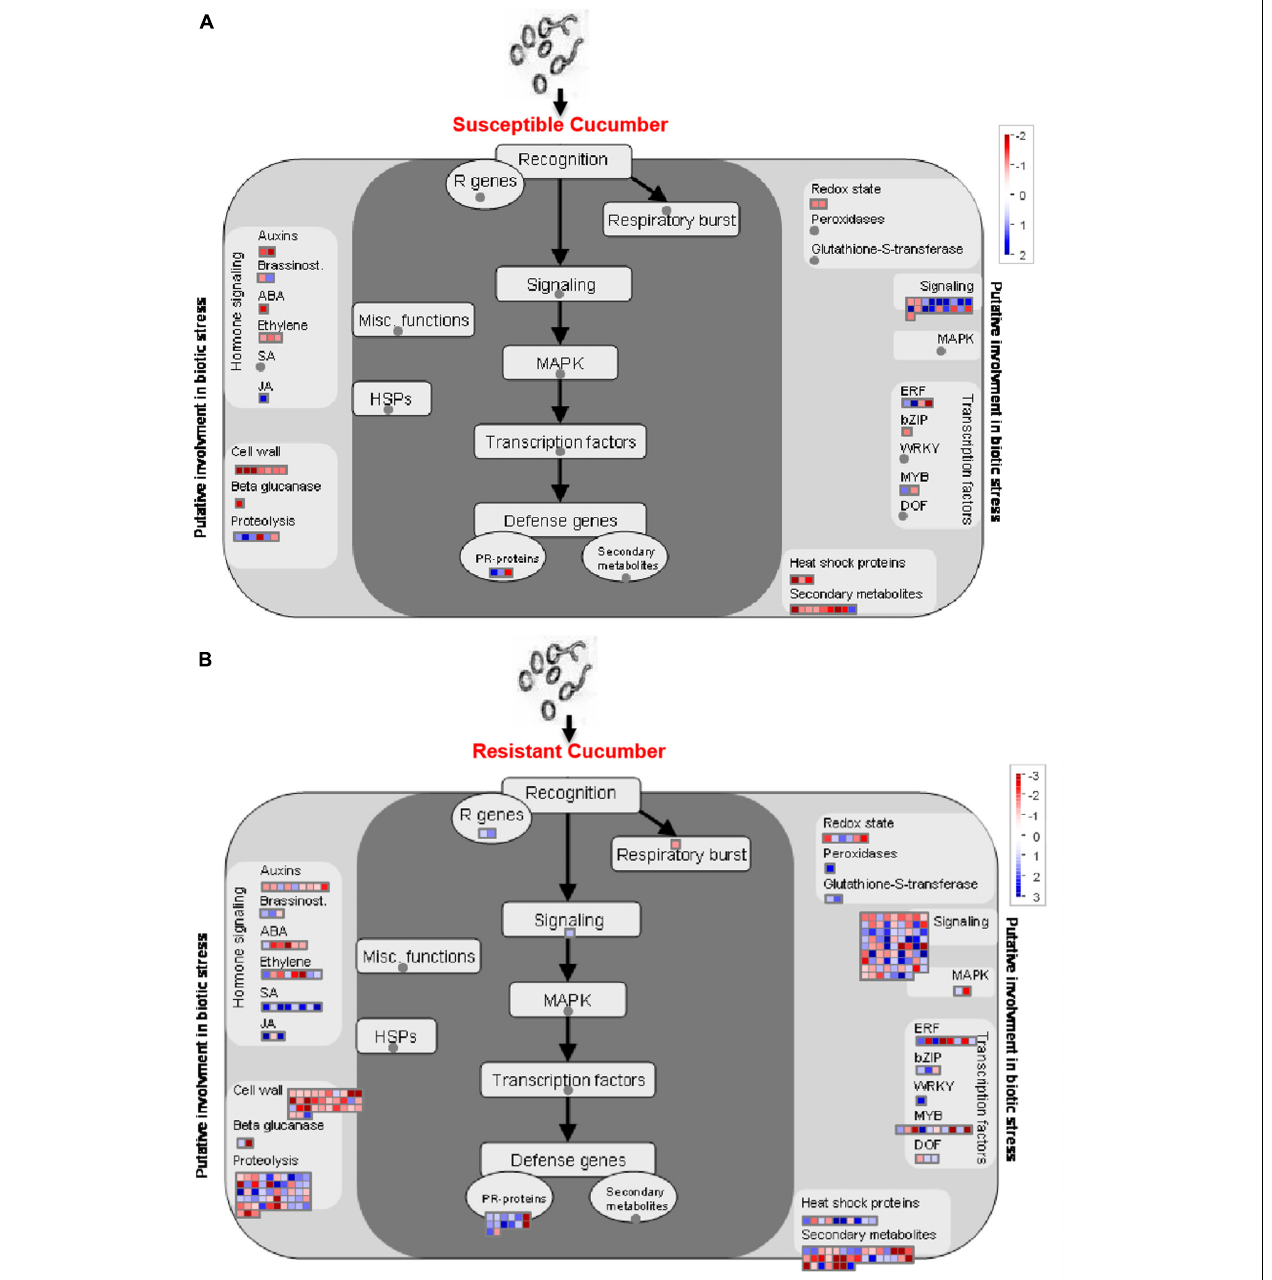
FIGURE 5 | Mapman analysis of DEGs in PM-susceptible cucumber strain B21-a-2-2-2 (A) and PM-susceptible cucumber strain B21-a-2-2-2 (B) subjected to infection with P. xanthii . The blue and red dots represent up- and down-regulated genes.